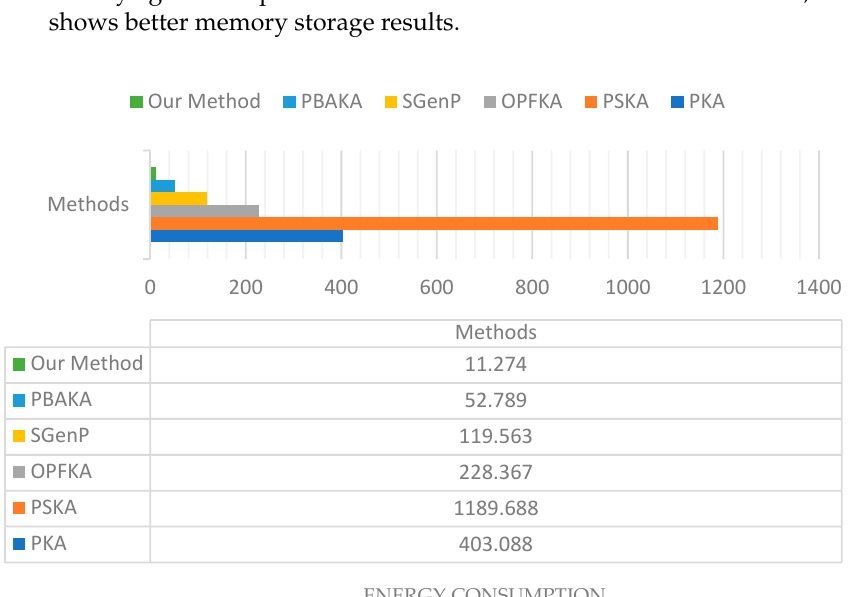
Figure 10. Total energy consumption in mJ for the proposed method and other methods.